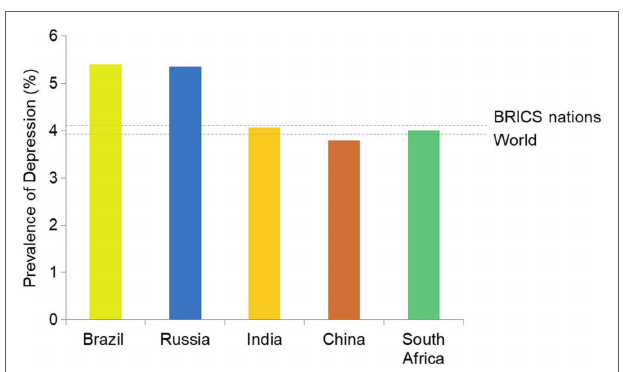
FIGURE 4 | Prevalence of individuals with depression among the population of BRICS